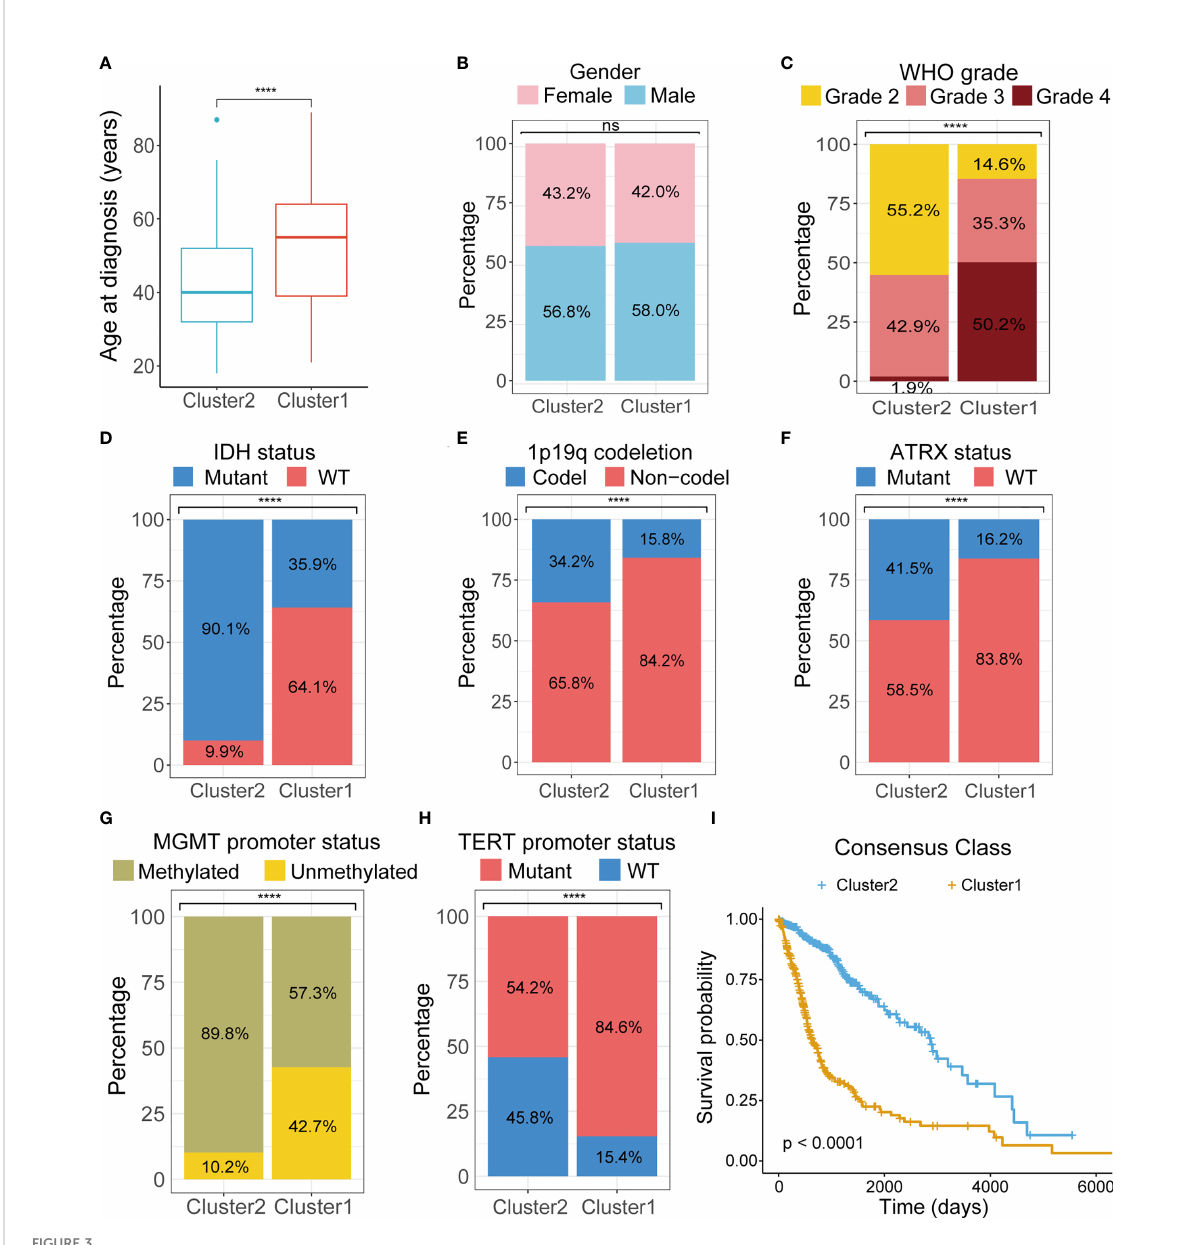
FIGURE 3 Comparison of clinicopathological characteristics between two clusters. Differences between two clusters were compared in age at diagnosis (A) , gender (B) , tumor grade (C) , IDH mutations (D) , 1p19q codeletion (E) , ATRX mutation (F) , MGMT promoter methylation (G) , TERT promoter mutation (H) . (I) K-M survival curves of two clusters. TCGA, The Cancer Genome Atlas; WHO, World Health Organization; IDH, isocitrate dehydrogenase; ATRX, Alpha Thalassemia Developmental Delay; MGMT, O6-methylguanine-DNA methyltransferase; TERT, telomerase reverse transcriptase; K-M, Kaplan – Meier; WT, wild type. ****p < 0.0001. ns, not signi fi